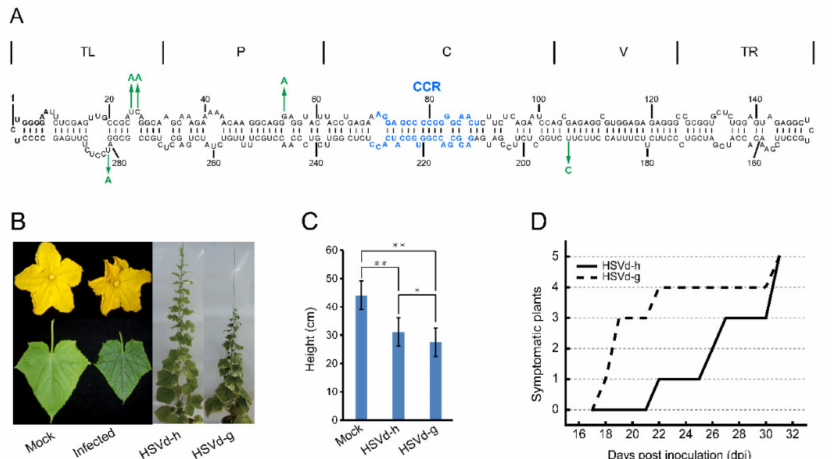
Figure 1. Symptoms of HSVd-g and HSVd-h infection in cucumbers. ( A ) The predicted secondary structure of HSVd-g. The five hop-adaptive mutations between HSVd-g and HSVd-h are indicated by green arrows. From left to right, the five structural / functional domains are terminal left (TL), pathogenicity(P), central (C), variable (V), and terminal right (TR). Central conserved region (CCR) in central domain is indicated by blue color. ( B ) Symptoms on cucumber at 28 days post-inoculation (dpi); left to right, flower, and leaf from healthy plant, flower, and leaf from the infected plant by HSVd-g or HSVd-h, and whole plants infected with HSVd-h or HSVd-g showing shortened internodes at 49 dpi. ( C ) Average height ( n = 6) of cucumber plants infected with HSVd-h or HSVd-g at 32 dpi. Single or double asterisks indicate statistically significant di ff erences at p < 0.05 or 0.01, respectively, in Student’s t -test. ( D ) Time course of symptom expression in cucumbers; solid and dashed lines show a number of symptomatic plants inoculated with HSVd-h or HSVd-g,